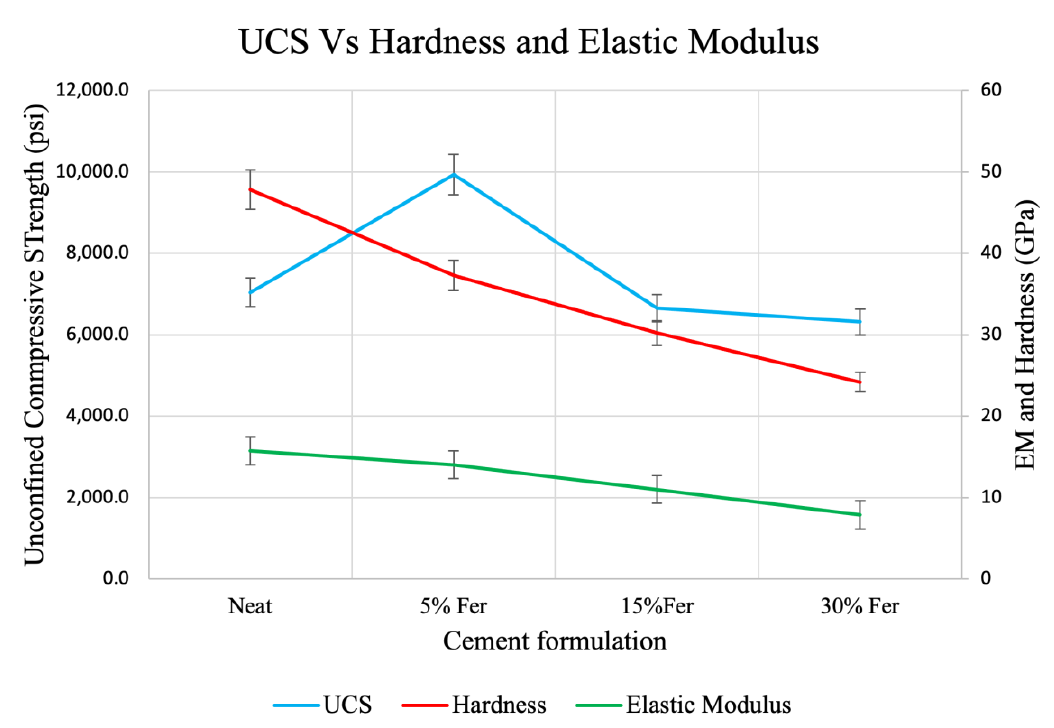
Figure 14. UCS versus indentation-derived hardness and elastic modulus for 5%, 15% and 30% ferrierite-added Class-H and neat Class-H cement, showing slightly similar trends. UCS is the highest for 5% ferrierite-added cement at 9934.3 psi compared to neat UCS at 7041.5 psi. Elastic modulus and hardness, on the other hand, are highest for neat Class-H with averages of 15.72 GPa (EM) and 47.82 (hardness) followed by the 5% ferrierite addition at 14.03 GPa (EM) and 37.3 (hardness). The hardness and elastic modulus decrease gradually with the increase in the percentage addition of ferrierite, which is a similar trend as that of UCS.